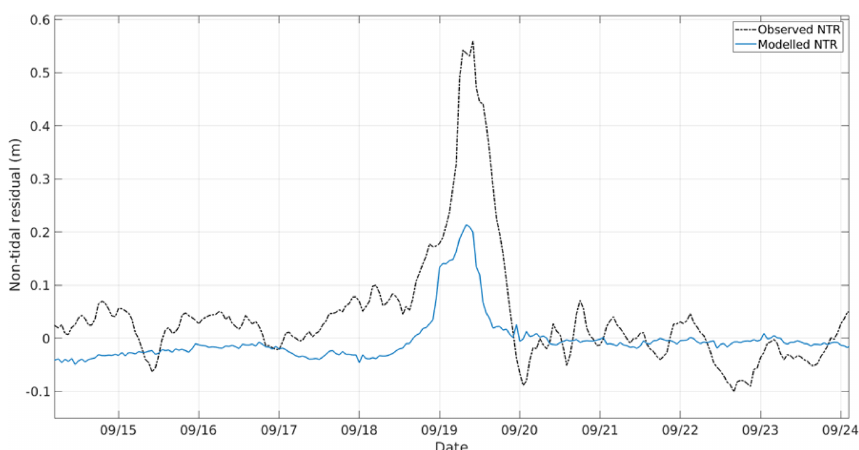
Figure 3. Modelled and observed non-tidal residuals (m) during the passing of Hurricane Maria (2017) over the Port-au-Prince tide gauge (Port-au-Prince,